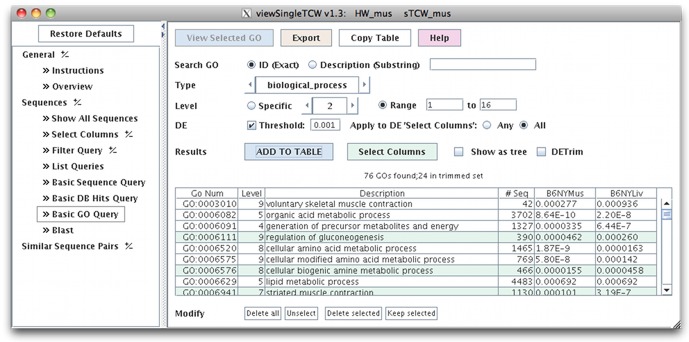
TCW trimmed GO set.All 76 DE-enriched GOs are shown in the table, and the 24 green rows are the trimmed set.